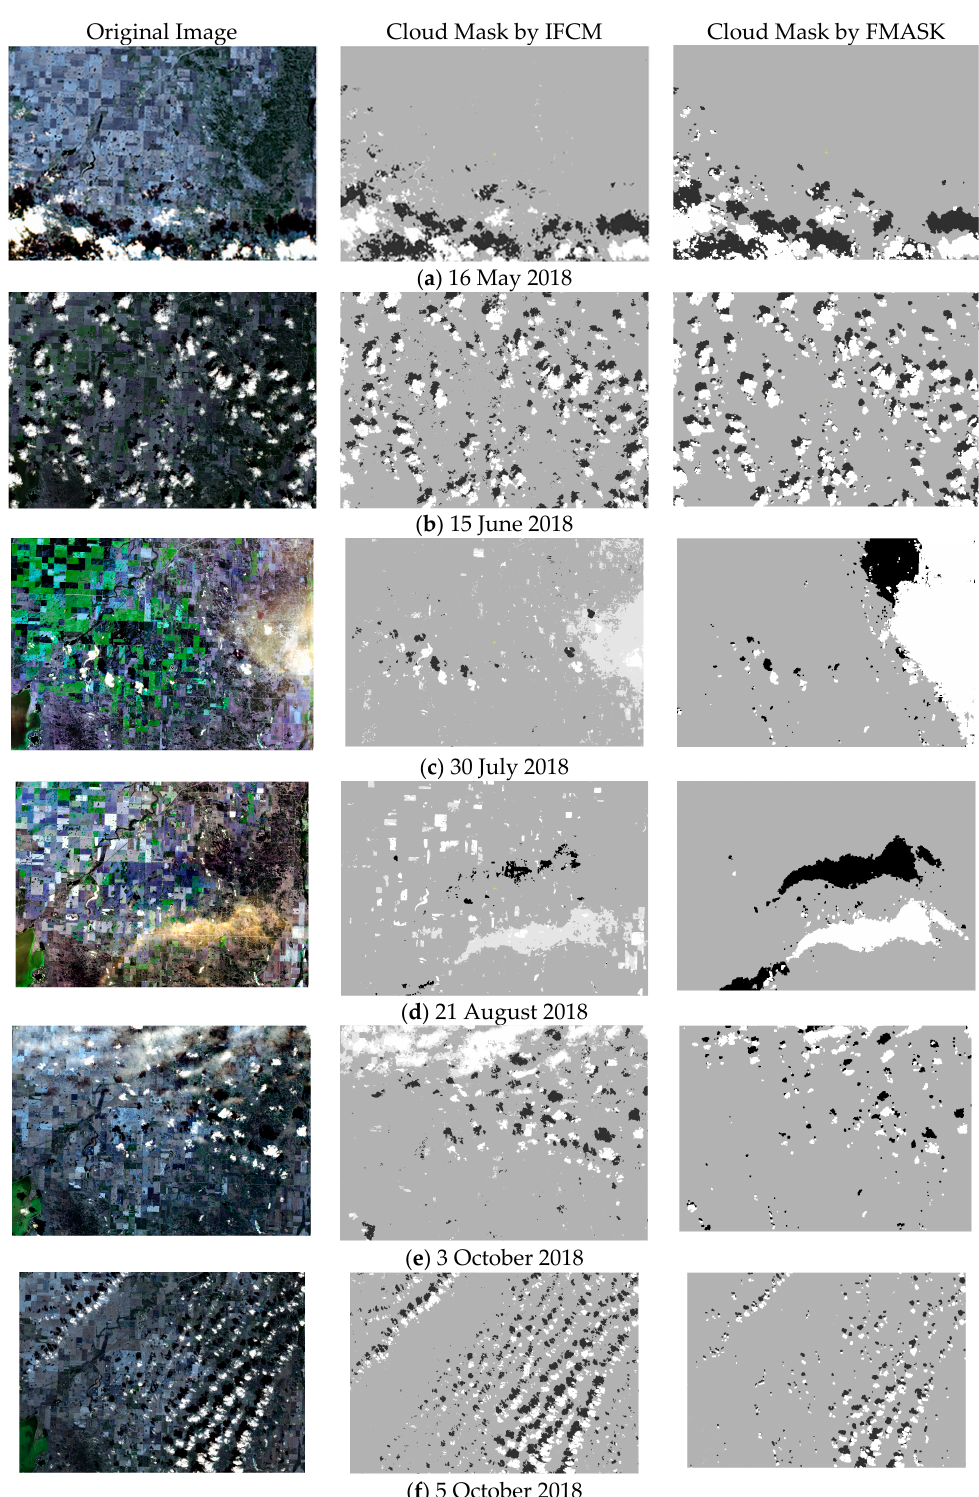
Figure 7. The six clouds and haze contaminated Sentinel ‐ 2 images acquired on ( a ) 16 May, ( b ) 15 June, ( c ) 30 July, ( d ) 21 August, ( e ) 3 October, and ( f ) 5 October 2018, and their haze, cloud, and cloud shadow masks generated by the image fusion cloud masking (IFCM) and the FMASK methods respectively. White indicates clouds, dark grey shows cloud shadows, light grey represents haze, and the rest is